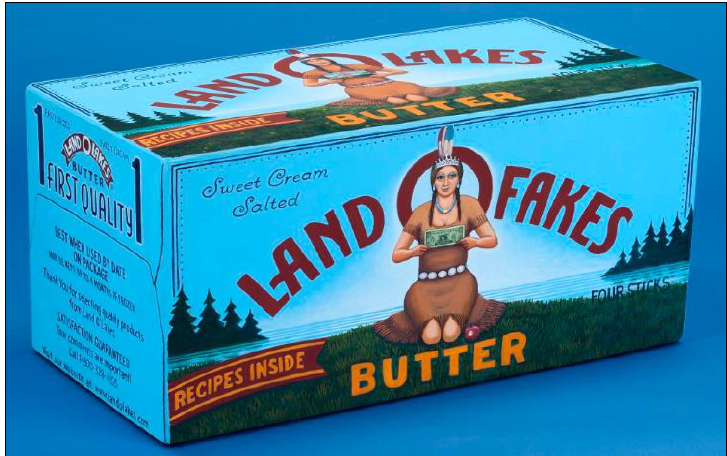
Figure 2. David Bradley, “Land O Bucks, Land O Fakes, Land O Lakes,” 2006.